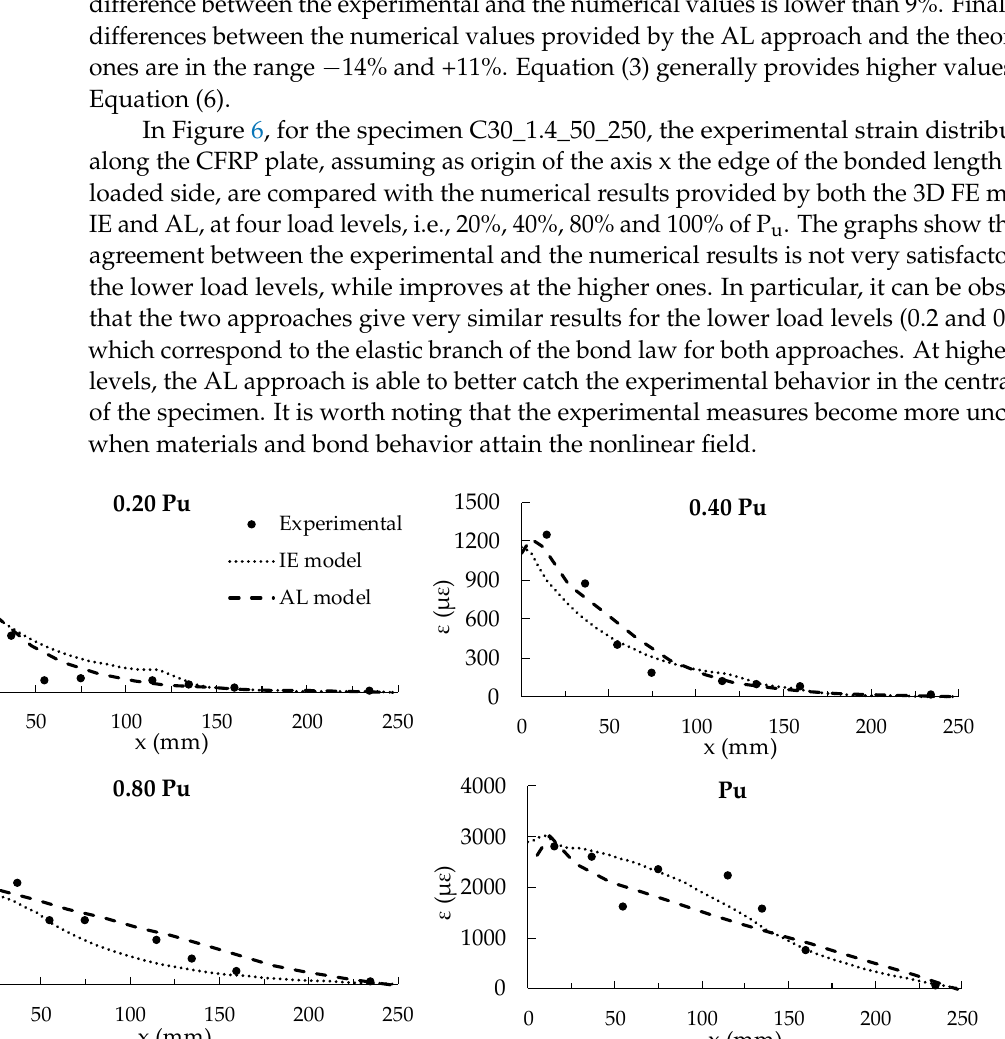
( d ) Figure 7. Longitudinal distribution of tensile stresses in the central section of the concrete block for the specimen C30_1.4_50_250 at: ( a ) 0.8 P u for IE model; ( b ) 0.8 P u for AL model; ( c ) at P u for IE model; ( d ) at P u for AL model.